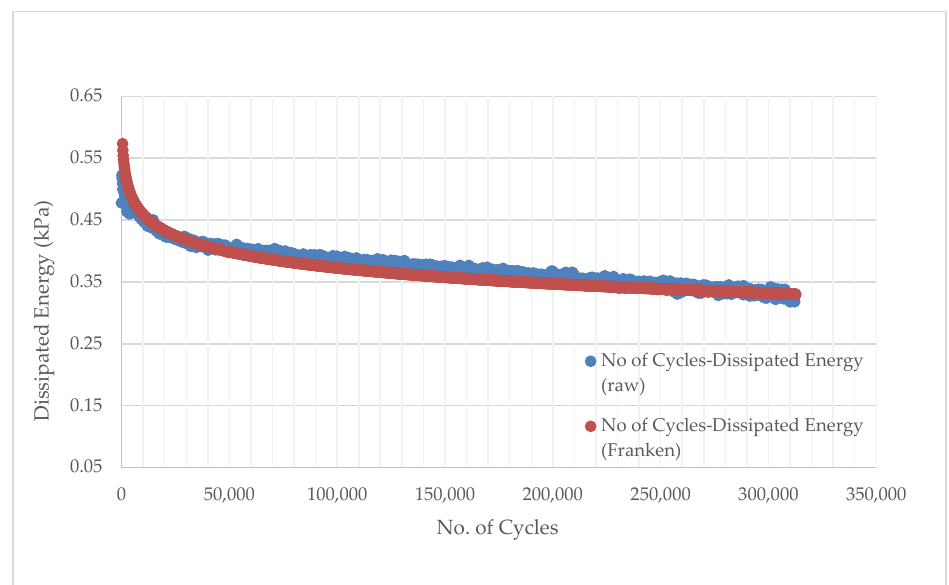
Figure 6. Typical plot between dissipated energy and loading cycles fitted with the Franken model [86].